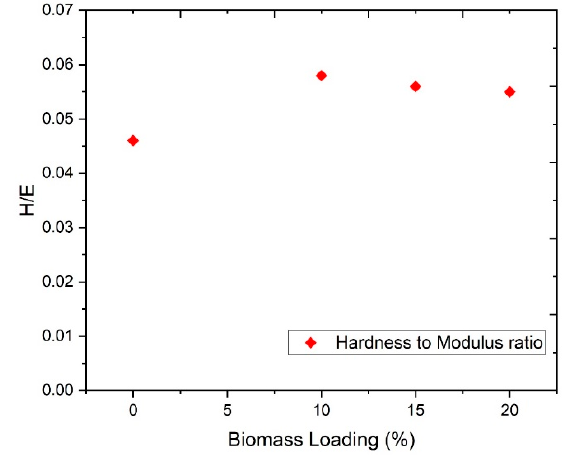
Figure 5. Hardness to modulus index of biocomposites with different pretreated RHW loadings (10, 15, and 20 wt.%). Materials 2020 , 13 , x FOR PEER REVIEW